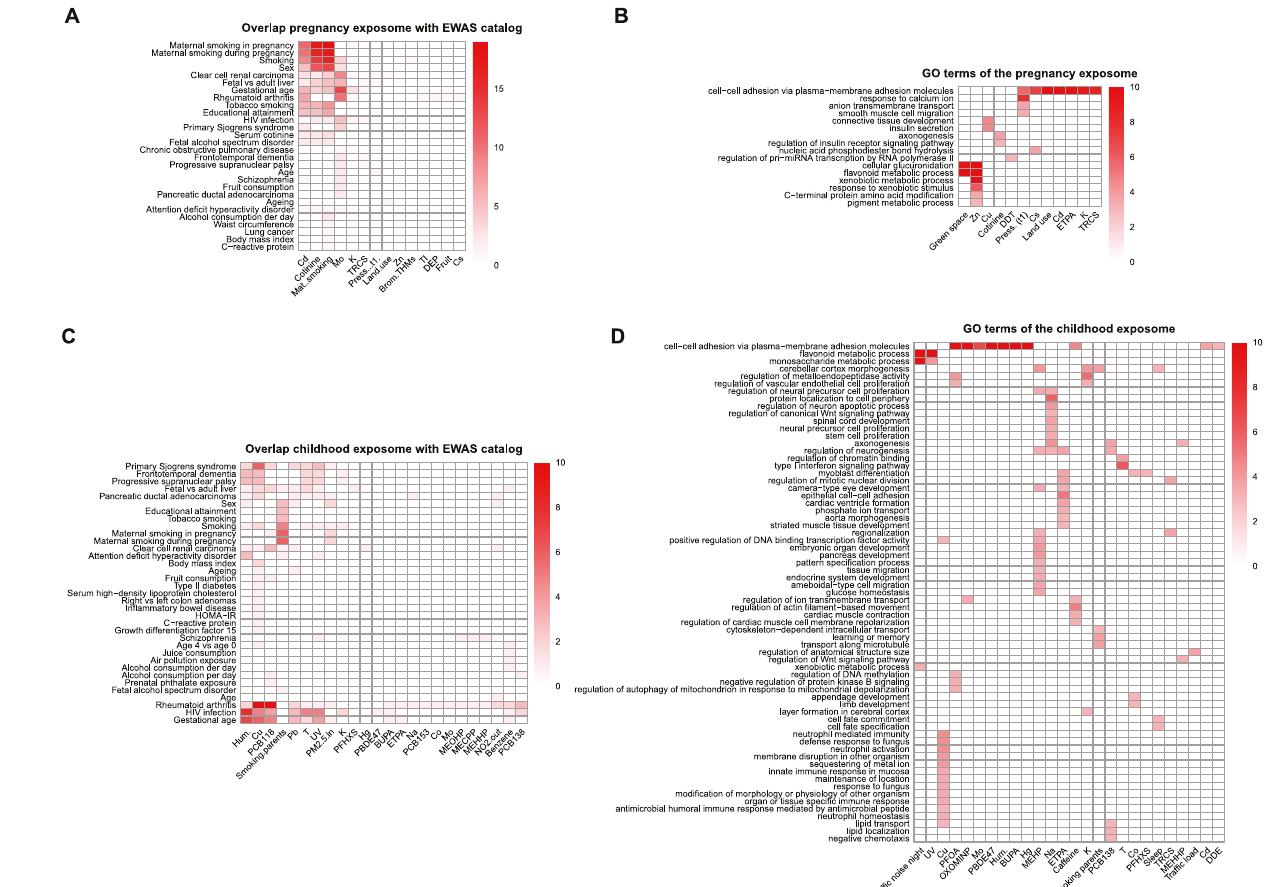
Fig. 6 | Biological interpretation of the exposome-omics associations through literatureoverlapandfunctionalenrichment.A OverlapofCpGsassociatedwith the pregnancy exposome (columns) with CpGs associated with traits/exposures in the EWAS catalogue (rows). B Functional enrichment analyses of the pregnancy exposome (columns) for Gene Ontology (GO) terms (rows). C Overlap of CpGs associated with the childhood exposome (columns) with CpGs associated with traits/exposures in the EWAS catalogue (rows). D Functional enrichment analyses